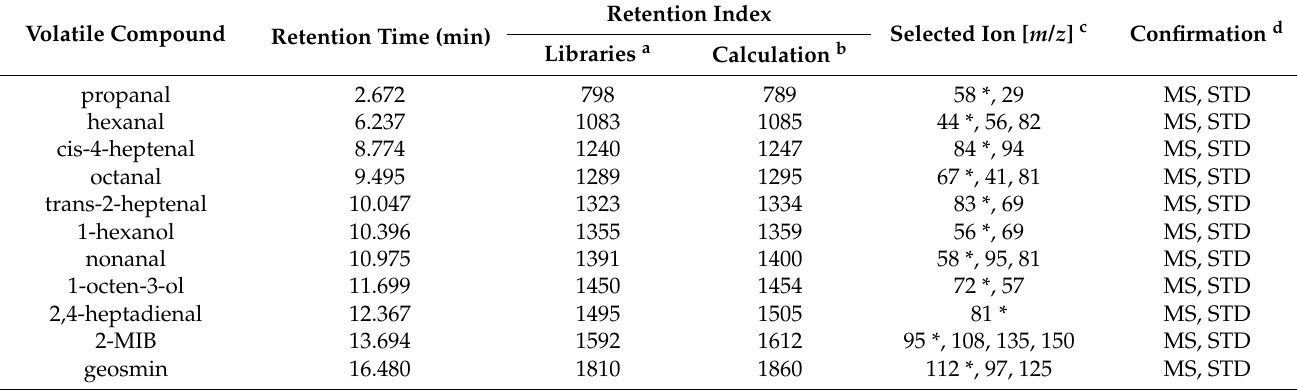
Table 1. Volatile target compounds in hybrid catfish muscle and their identification